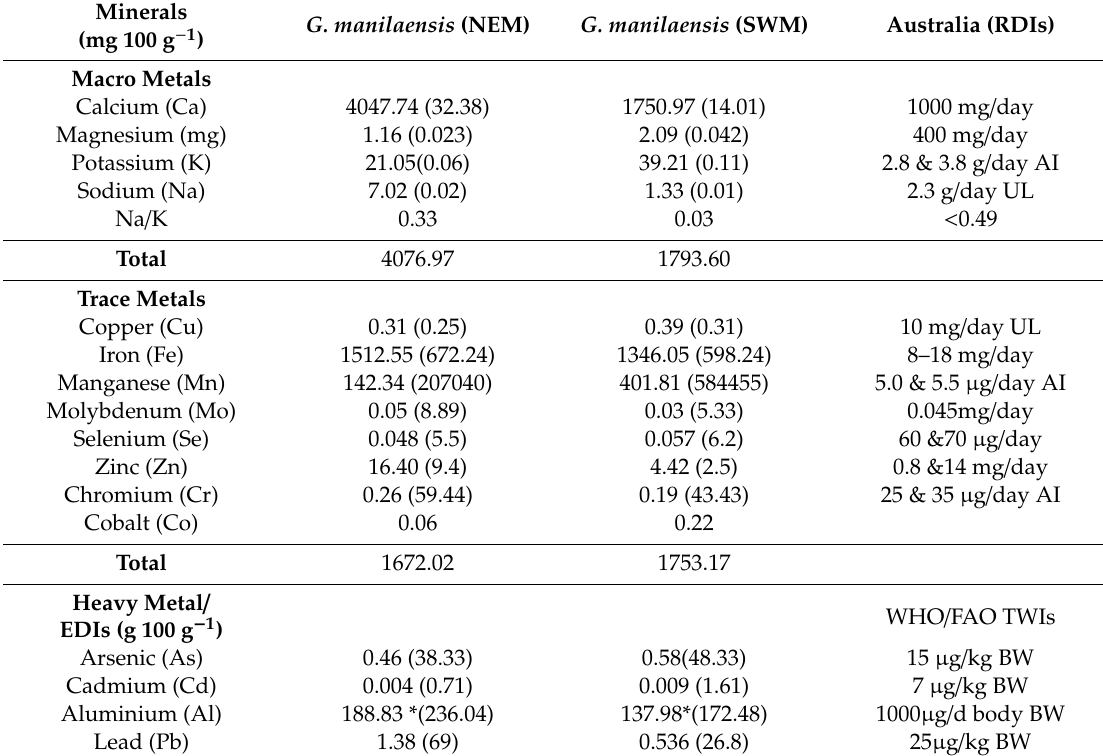
Table 4. Seasonal Variation in the Mineral Composition (mg 100 g − 1 DW) of Edible G. manilaensis as Compared With the Dietary Reference Intake Values (RNI) (8 g Day − 1 ) of Australia.